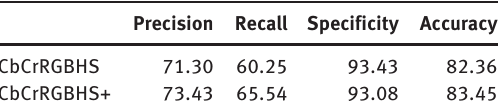
Table 9. Accuracy Results for CbCrRGBHS+ on the UCD Database.